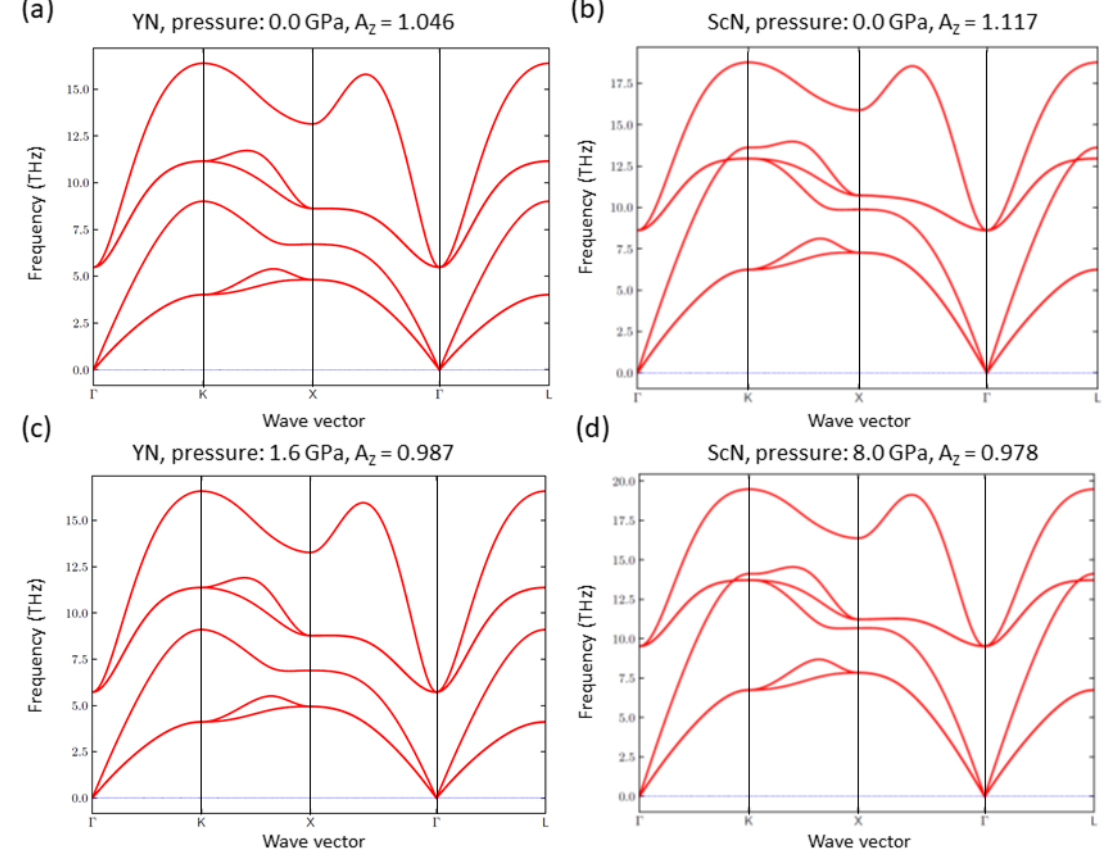
Figure 6. Quantum-mechanically calculated phonon dispersions at zero pressure for YN ( a ) and ScN ( b ) and for YN also for the hydrostatic pressure p = 1.6 GPa ( c ) and for ScN for p = 6.5 GPa ( d